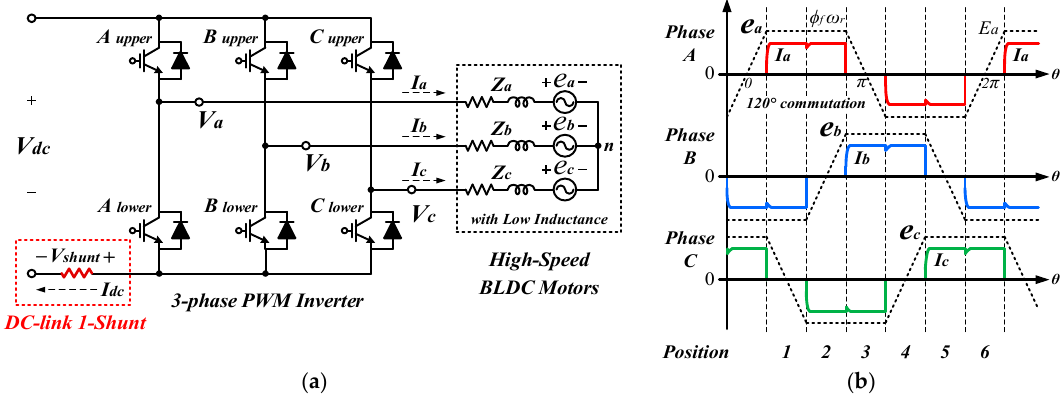
Figure 2. Three-phase brushless dc (BLDC) motor inverter system: ( a ) Three-phase BLDC motor inverter system with DC-link single-shunt current; and ( b ) Waveforms of three-phase current and back EMF.